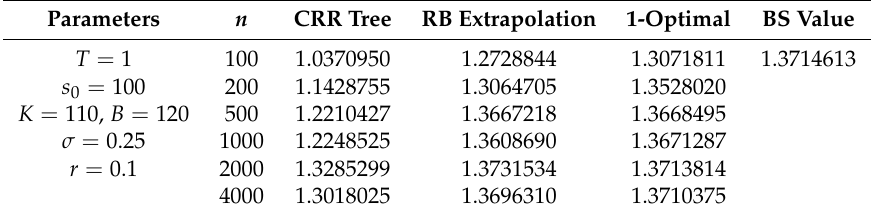
Table 1. Convergence behaviour of CRR, RB with extrapolation and the 1-optimal